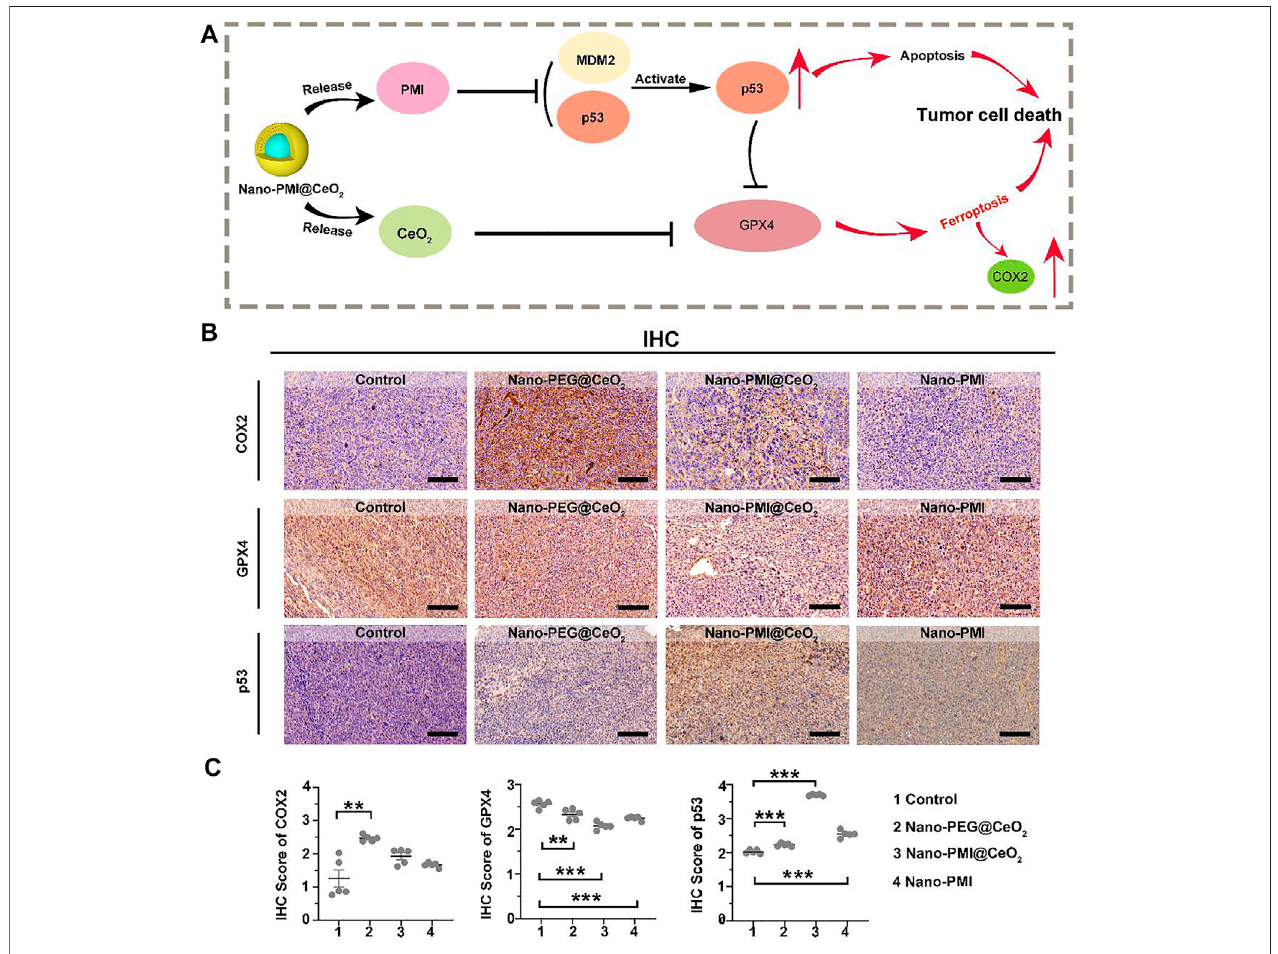
FIGURE 5 | Mechanism of Nano-PMI@CeO 2 in vivo induced tumor cell death. (A) Schematic diagram for antitumor activity of Nano-PMI@CeO 2 targeting the p53 pathways and inducing ferroptosis. (B) Representative IHC staining of COX2, GPX4, and p53 in tumor sections. (Scale bar:100 μ m). (C) IHC scores analysis presented intratumoral protein levels of p53, GPX4, and COX2. p values were calculated by t -test (*, p < 0.05; **, p < 0.01; ***, p < 0.001).